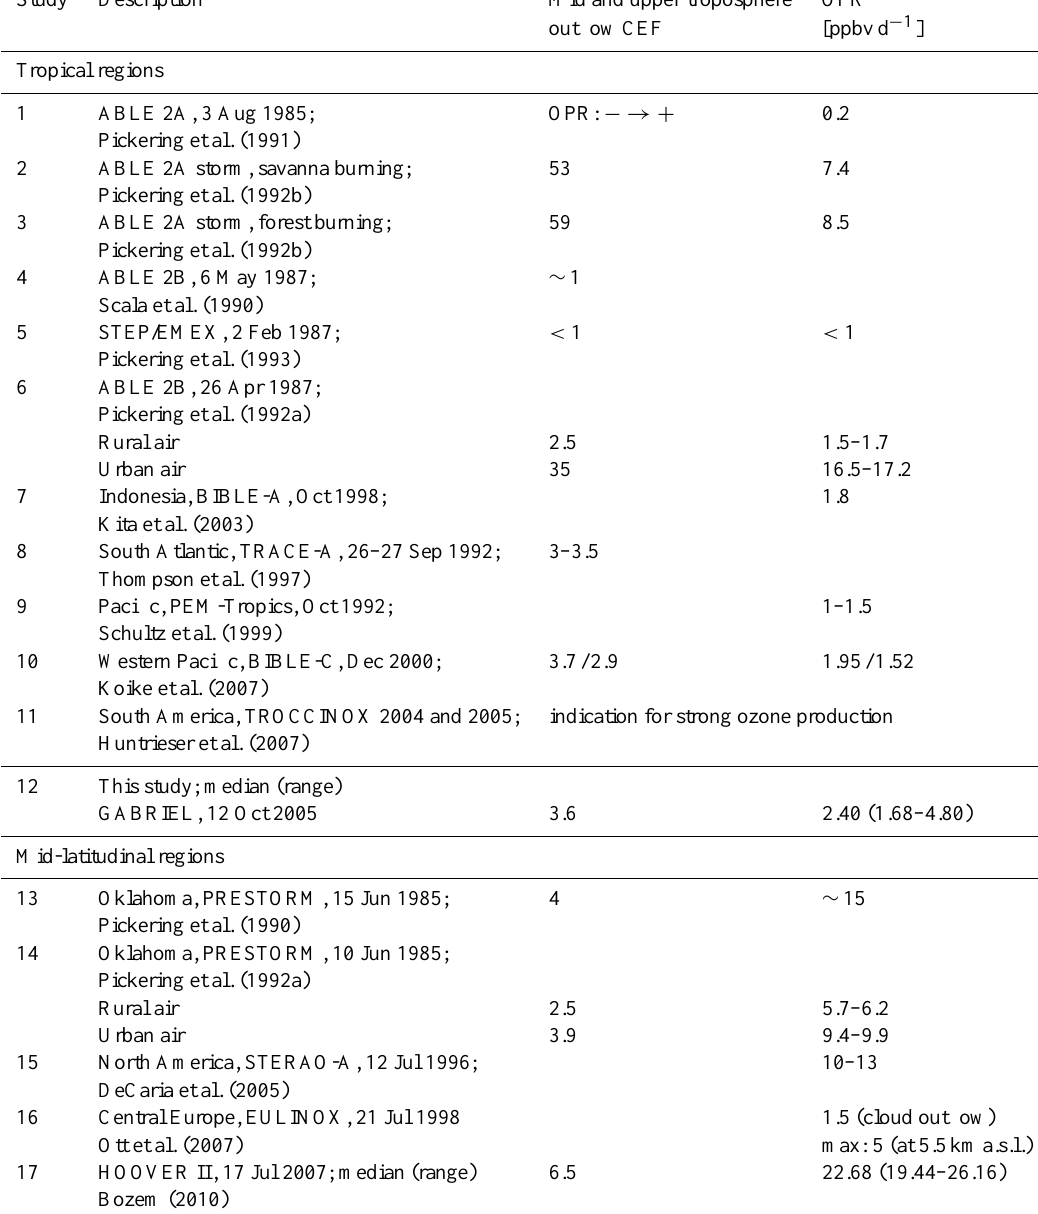
Table 3. Convective ozone production enhancement (adopted and modified from Pickering et al.,